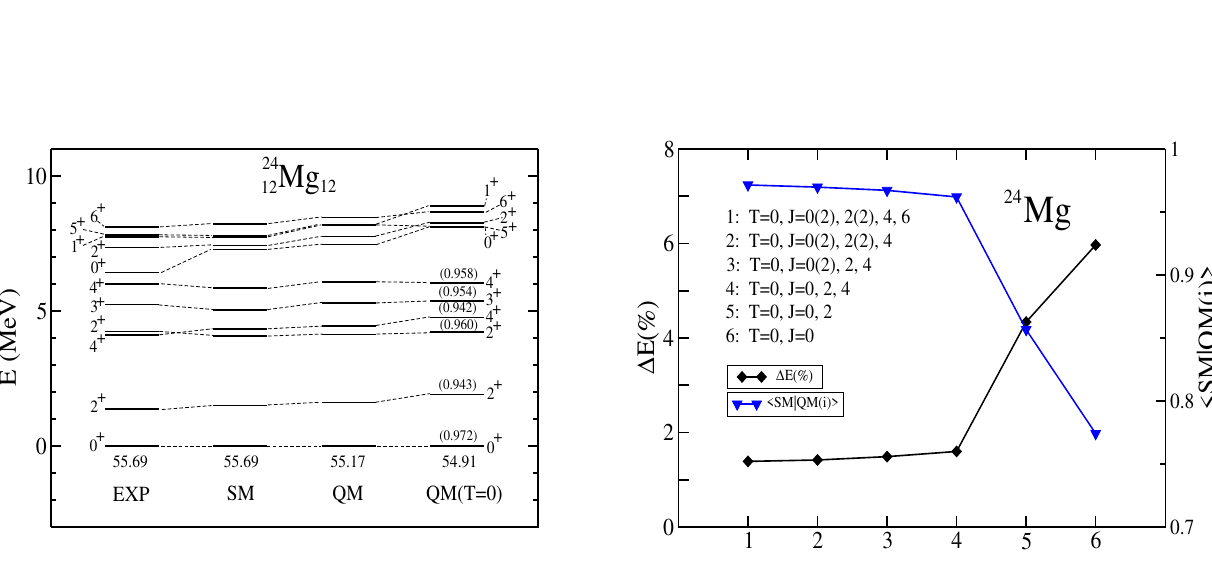
Figure 1. Spectrum of 24 Mg obtained in the quartet model (QM) compared to experimental data (EXP) and shell model (SM) re- sults. QM(T = 0) denotes the results obtained only with T = 0 quar- tets; the numbers on top of these levels are the overlaps between the QM and SM eigenfunctions. The number below each spec- trum gives the ground state correlation energy, namely the di ff er- ence between the total ground state energy and the energy in the absence of interaction.